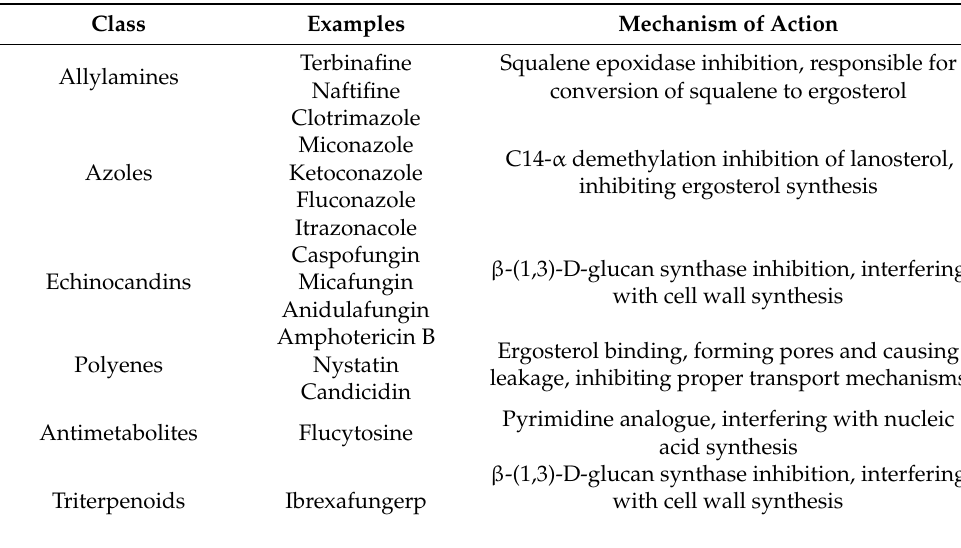
Table 7. Current antifungal classes and their mechanisms of